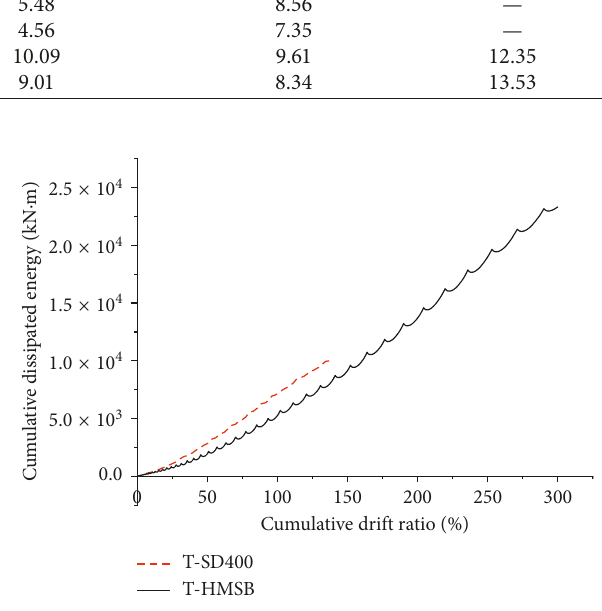
Figure 14: Cumulative dissipated energy for test specimens.